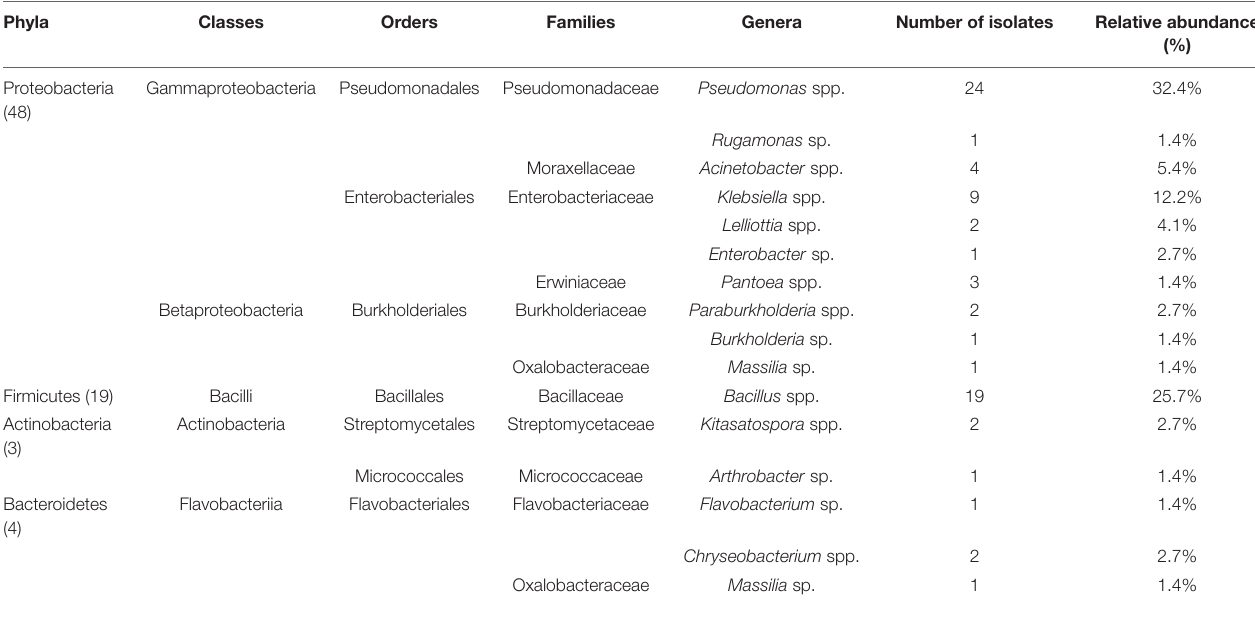
TABLE 1 | Taxonomy information of rhizospheric bacteria of mulberry